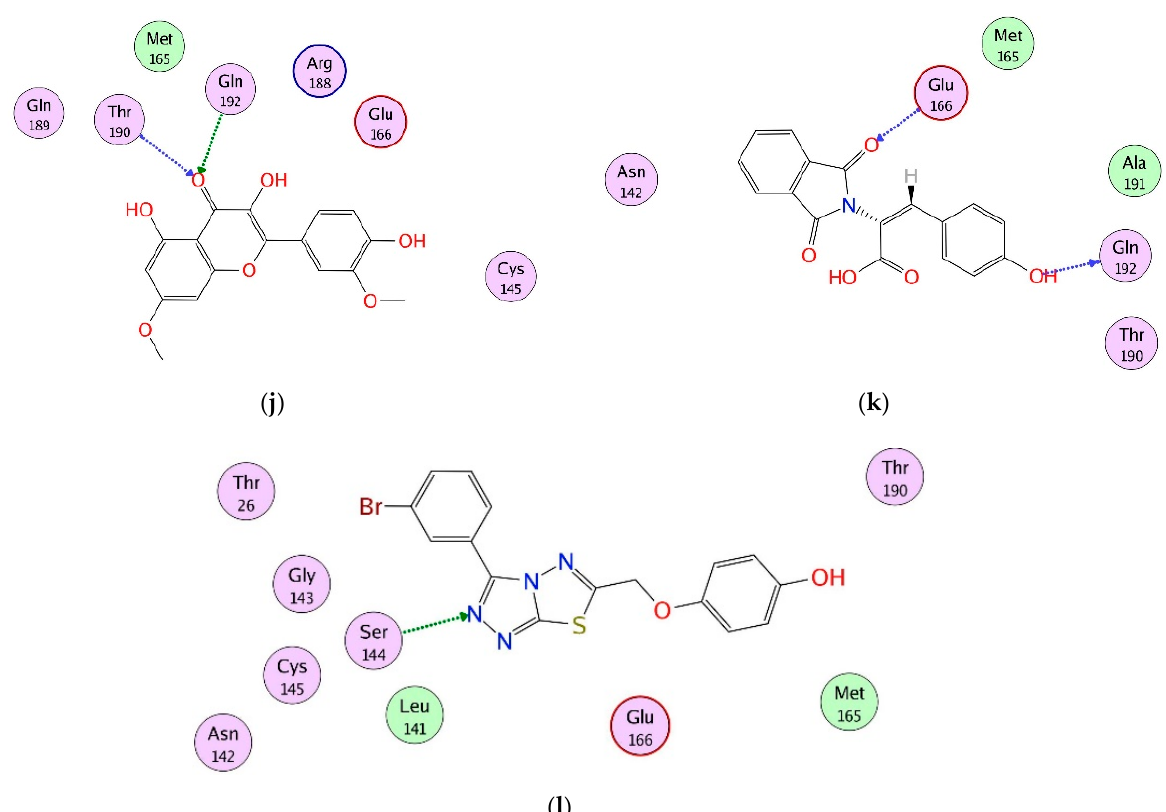
Figure 1. ( a ) The 3D structure of M pro is shown in complex with X77 (green stick model). The active site residues are displayed in orange stick models. The S1–S5 subsites are highlighted. The protein–ligand binding interactions of compounds 1, 3, 6, 8, 10 – 13, 17, 18, and 28 are shown in 2D format in ( b )–( l ), respectively. Hydrogen bonds are depicted in dotted arrows. The green and blue colored arrows represent side chain acceptor/donor and backbone acceptor donor atoms, respectively.